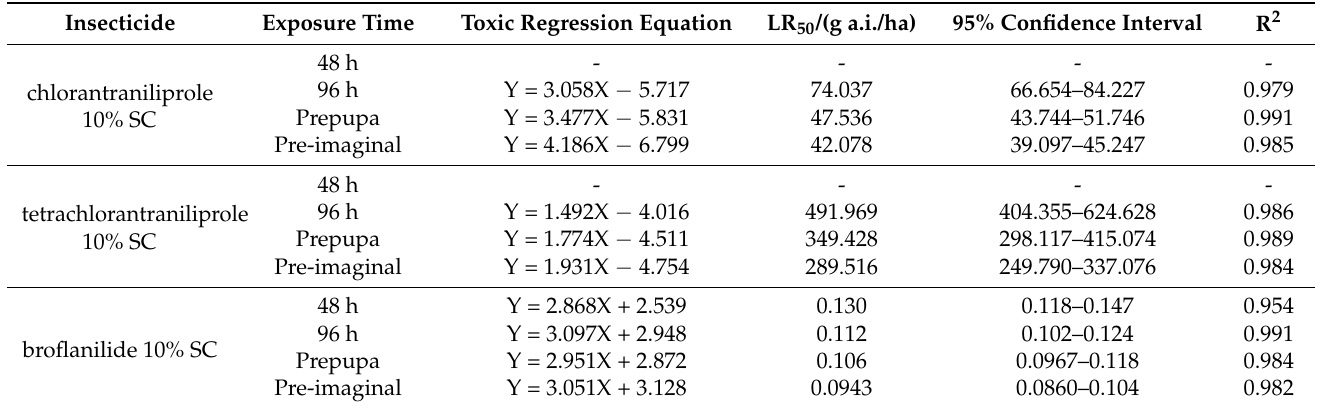
Table 2. The half-lethal dose (LR 50 ) of three diamide insecticides in the larvae of C. septempunctata